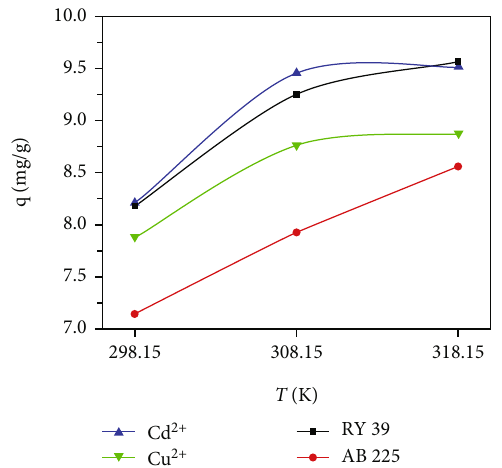
Figure 11: The e ff ect of temperature on the pollutants ’ adsorption onto